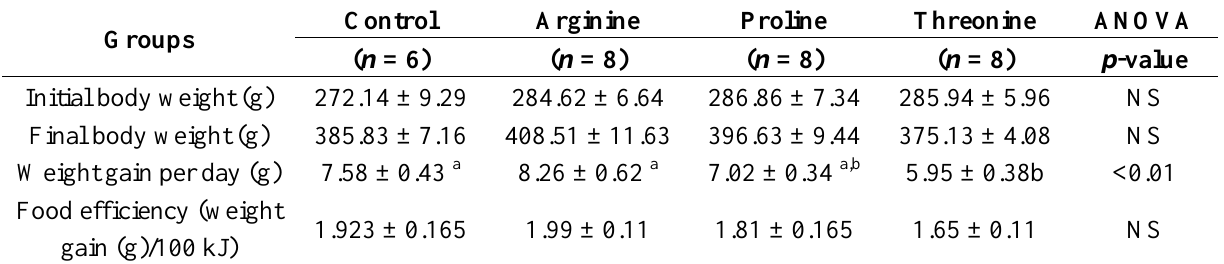
Table 5. Mean weight (g) of rats fed on diets supplemented with 5% arginine, proline or threonine.